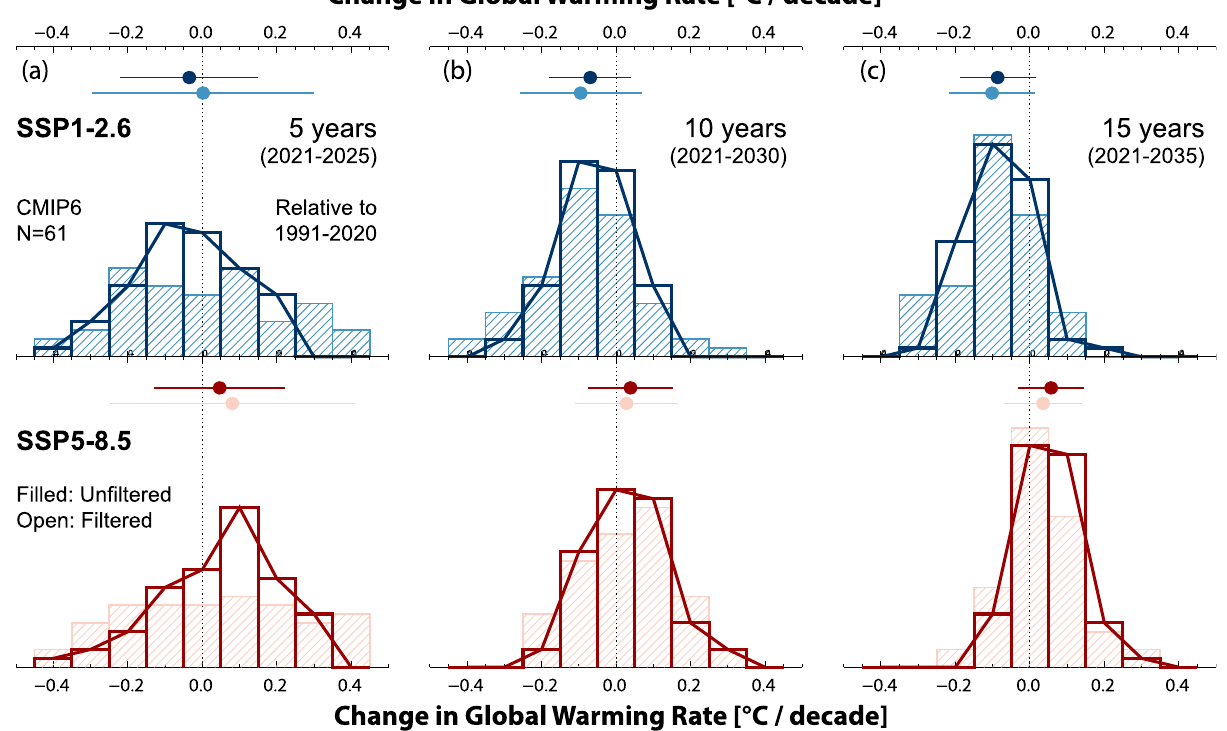
Fig. 5 Change in global mean warming rate, relative to the recent 30-year period (1991 – 2020). Emissions following two future Shared Socioeconomic Pathways (SSP1 – 2.6 and SSP5 – 8.5), for a range of CMIP6 models and realizations of internal variability. a 5-year rates. b 10-year rates. c 15-year rates. Hashed histograms show rate changes in the un fi ltered simulation results, open histograms and lines show Green ’ s function fi ltered results. Dots-and- whiskers show the means and ±1 standard deviation ranges of the